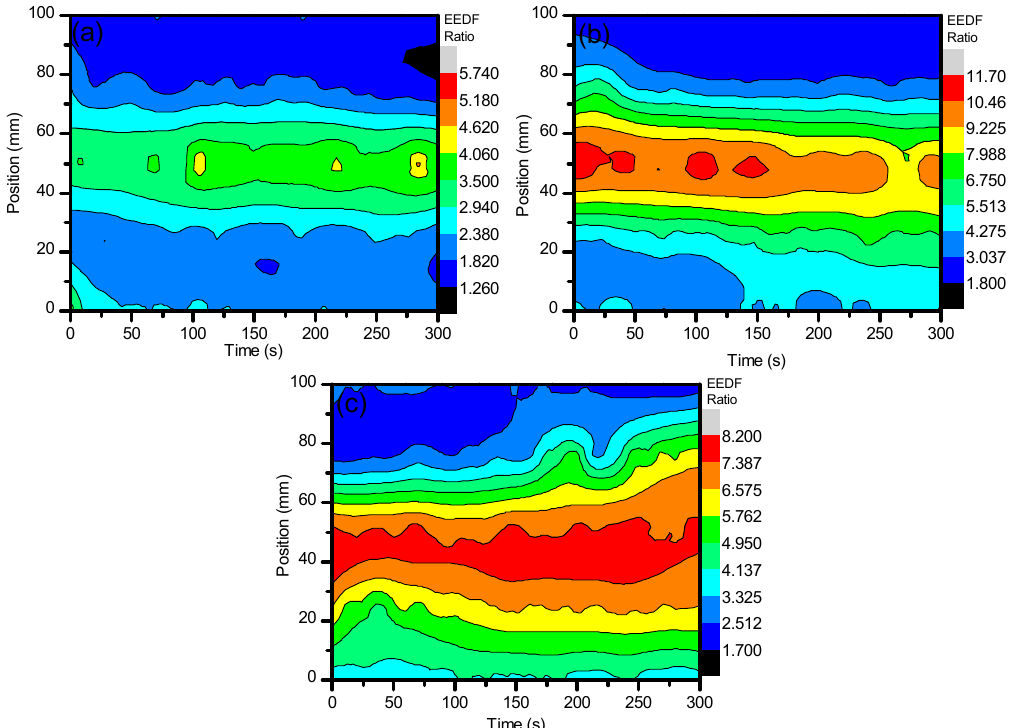
Figure 4. Shows the line ratio of (N 2 -337/N 2+ -391) when using ambient air with ≈ 3.8% CO 2 . This portrays how the electron energies were altered with the different parameter settings, most importantly the variation of working gas composition. ( a – c ) represent discharge at 27, 29.6, and 32 kV, respectively.